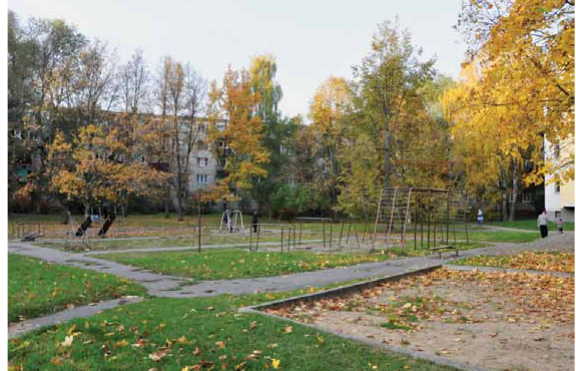
Fig. 4. new infill in the existing urban structure impact quality of usage of open